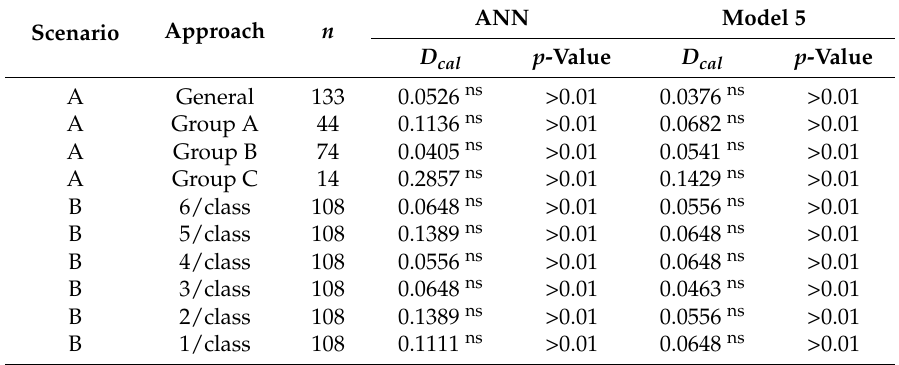
Table A5. Results of the Kolmogorov–Smirnov test calculated ( D cal ) for validation of the predicted values by ANN and equations with Model 5 in all approaches to scenarios (a) and